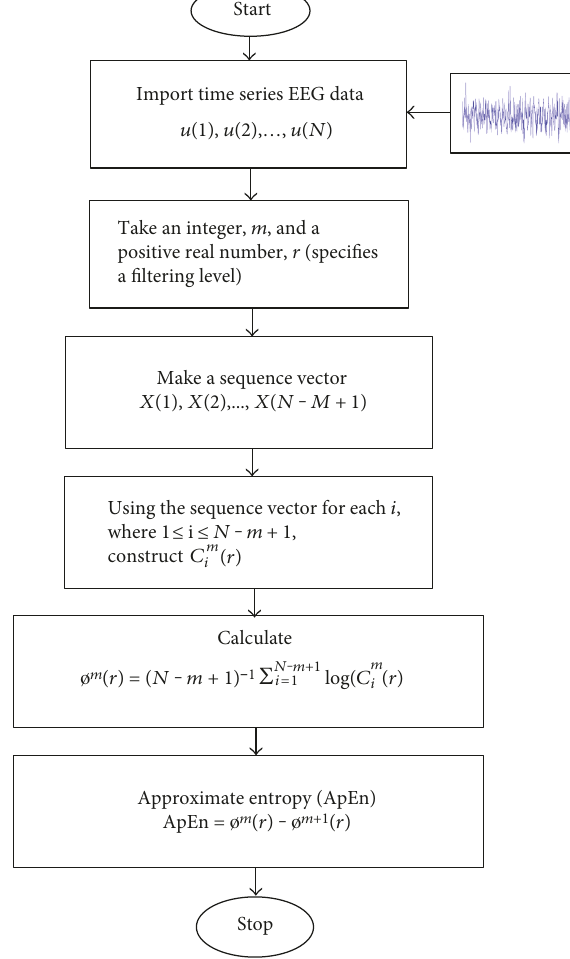
Figure 3: Computational fl ow diagram for